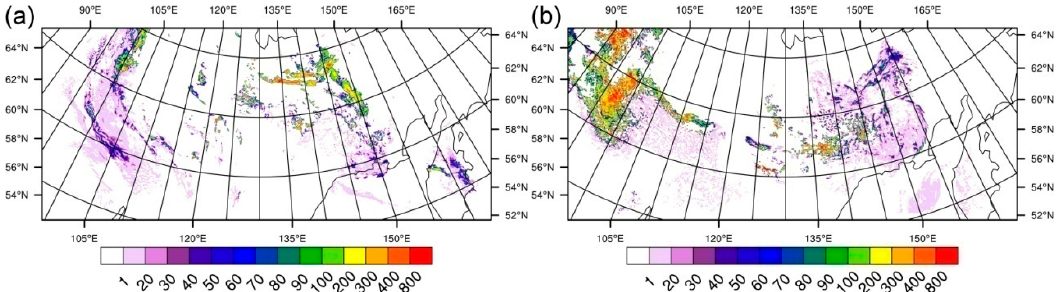
Figure 8. ( a ) SRB SW TOA ↑ , ( b ) SW TOA ↑ modeled by SMOKE and ( c ) CLEAN during FP2 at 0600 UTC on 19 August 2002. ( d ) SRB SW TOA ↑ , ( e ) SW TOA ↑ modeled by SMOKE and ( f ) CLEAN during FP2 at 0600 UTC on 20 August 2002. ( g ) SRB SW TOA ↑ , ( h ) SW TOA ↑ modeled by SMOKE and ( i ) CLEAN during FP2 at 0600 UTC on 21 August 2002. The white line on ( b ) shows the cross-section as discussed in Figure 10. The white square on ( c ) indicates the region used for analysis in Figure 11.